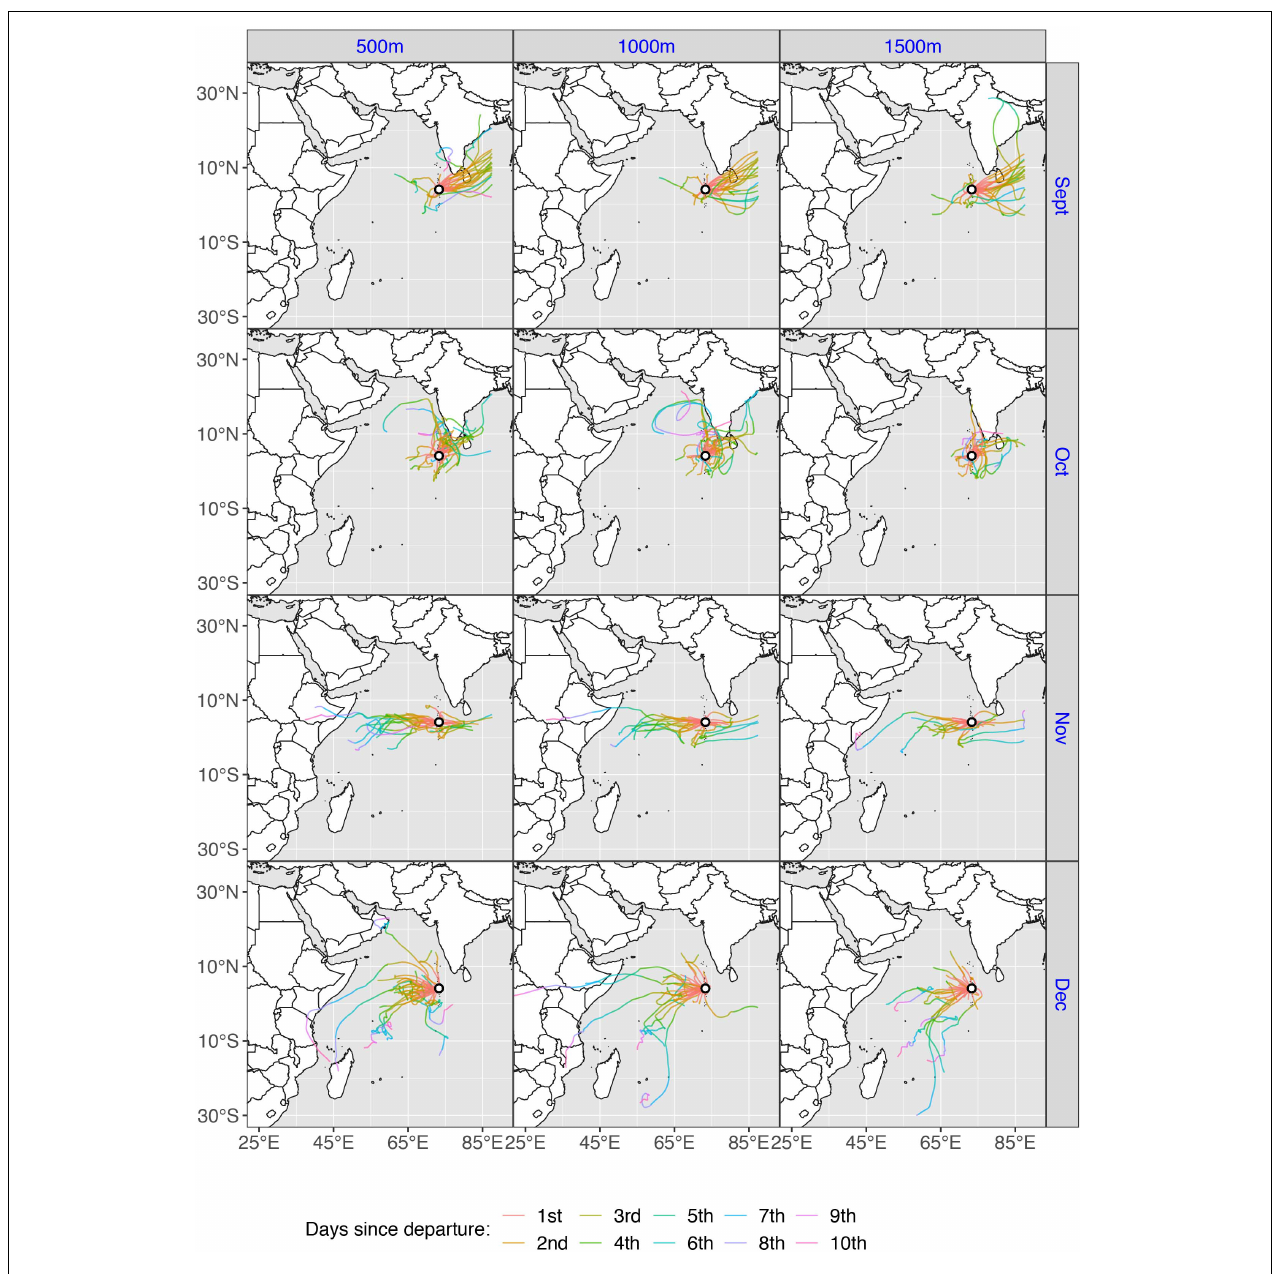
FIGURE 6 | Autumn wind trajectories ( N = 366), during September–December, for three starting heights (500, 1,000, and 1,500 m) from the departure site Malé, the Maldives. Colors denote the number of days since departure (1–10). As the model adheres to a limited geographical scope, trajectories that exceeded the boundary (approximately 87 ◦ E longitude) will stop, thus trajectories traveling eastward across the Bengal Sea are cut